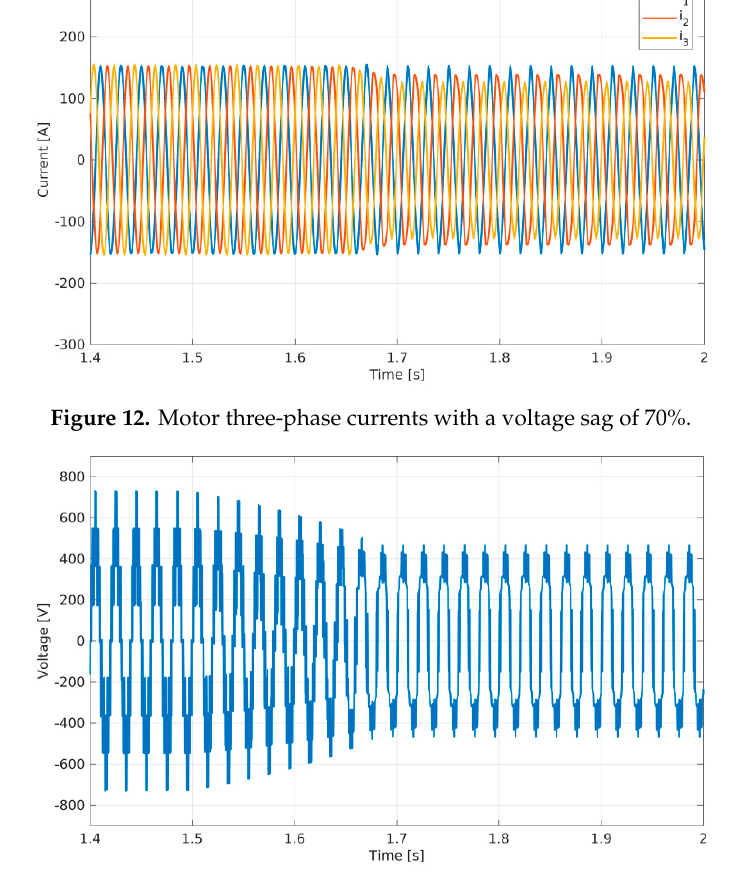
Figure 13. Phase voltage applied to winding 1 with a voltage sag of 70%.